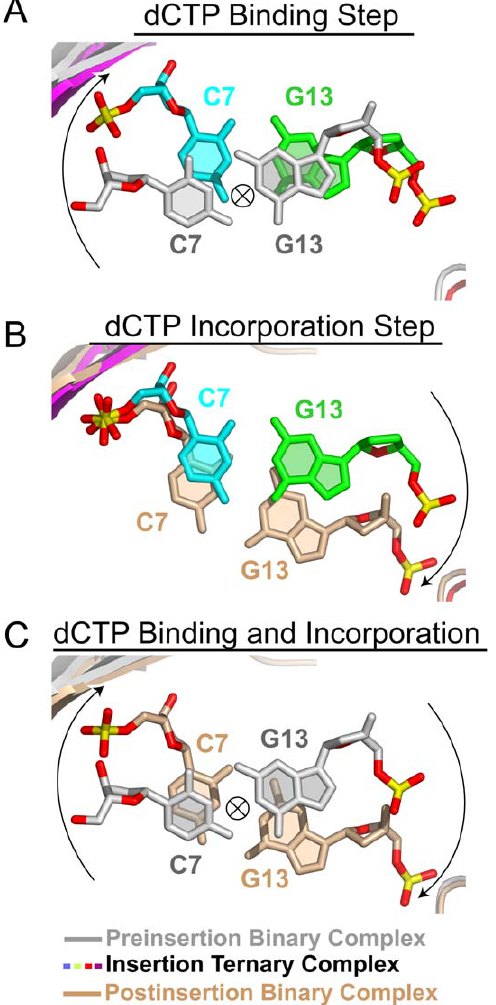
Figure 10. Comparison of the Relative Progression (Twist Angle Viewed down the Helix Axis) of C7 (cid:2) G13 Pairs between Complexes Super- positioned on their Finger and Palm